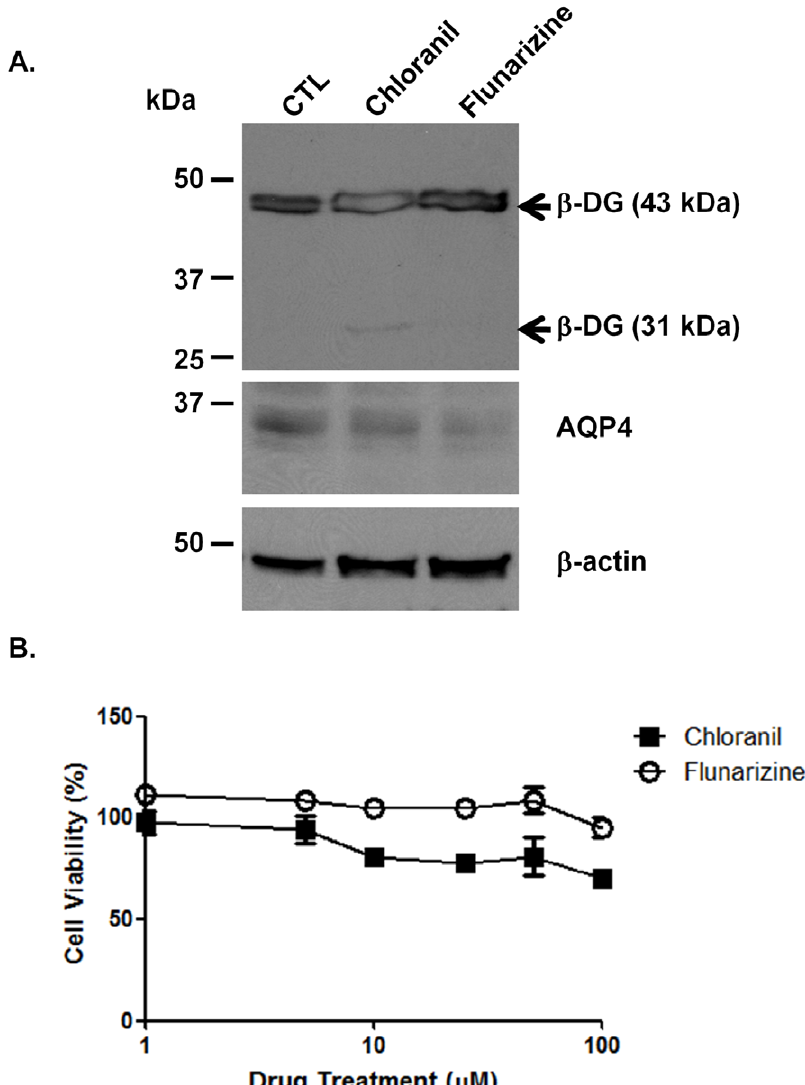
Figure 5. Effect of chloranil and flunarizine on astrocyte survival and ß-dystroglycan, and AQP4 expression. A. Primary astrocytes were incubated for 4 h with 15 m M of active chemicals. Extracted proteins were loaded (30 m g/lane) and analyzed for ß-DG, syntrophin and AQP4 expression levels by western blot analysis. Note the 31 kDa band under the 42 kDa band corresponding to the cleaved form of ß-dystroglycan upon chloranil treatment. B. Primary astrocytes were incubated for 4 h with different concentrations of the active chemicals. Chemicals and media were washed away and the cells were assayed for cell viability by MTT assay.